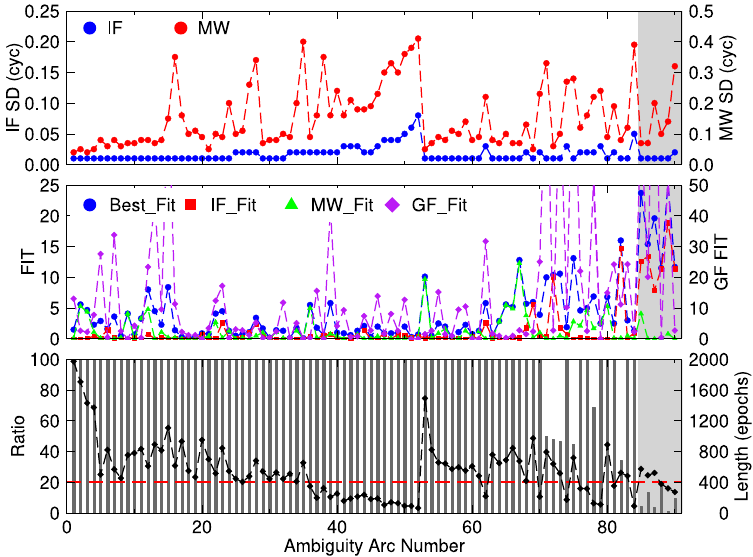
Figure 3. Ambiguity resolution of each arc with IF observations. The experimental data is from NNOR-PERT on DOY 84 2019. The top panel shows the standard deviations of the IF estimates referring to the left axis and the MW combinations to the right. The middle panel denotes the fit values computed with (26) and (27). Notes the axis of GF fit values is shown on the right. In the bottom, the ratio values calculated with (28) are shown. The red dash line indicates the lowest threshold of 20. The diamond symbols denote the length of the arc referring to the right vertical axis. The gray background means the unfixed ambiguity arcs.